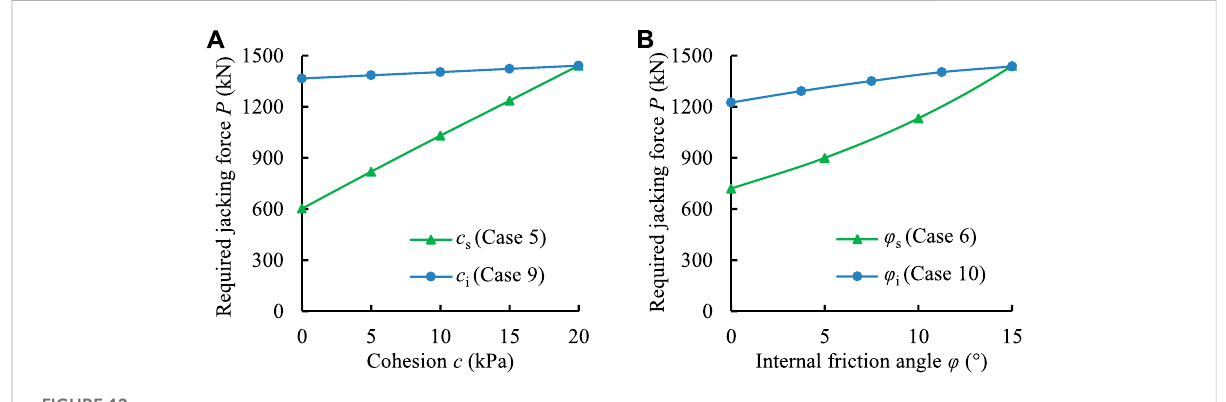
FIGURE 12 Variations of the required horizontal force P with the shear properties of soil-pile interface and soil: (A) Cohesion c (Cases 5 and 9) and (B) internal friction angle φ (Cases 6 and